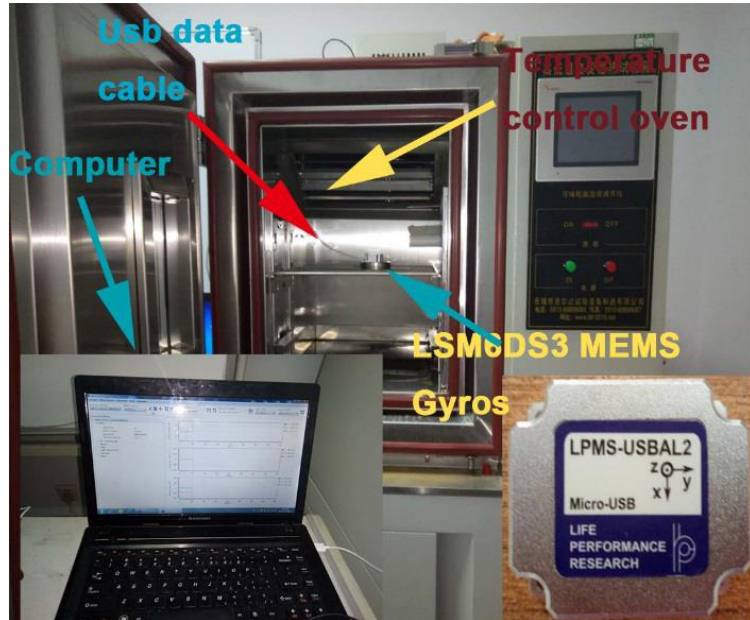
Figure 11. Equipment of the temperature test.